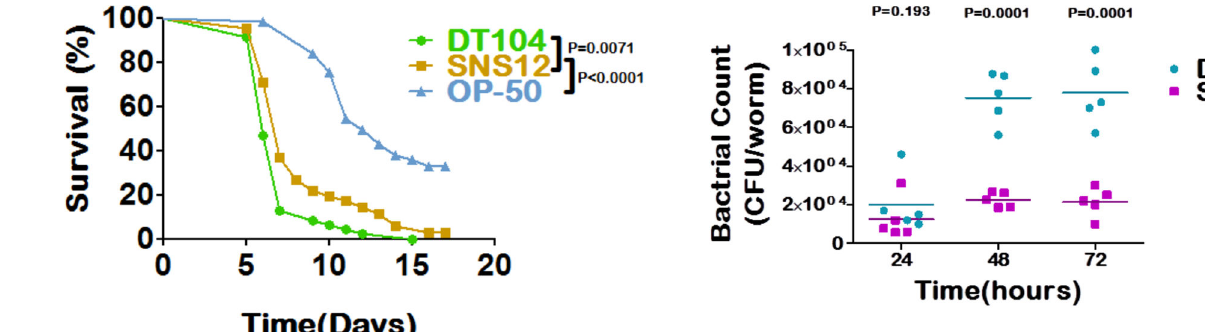
Figure 2. Salmonella Typhimurium DT104 colonization in C. elegans intestine is enhanced due to MDR genes. L1 stage N2 worms were exposed to DT104 (--●--) and SNS12 (-- ■--), and the extent of colonization was determined every 24 hours. Each data point represents the colony forming unit per worm (CFU worm -1 ) from a pool of 10 infected